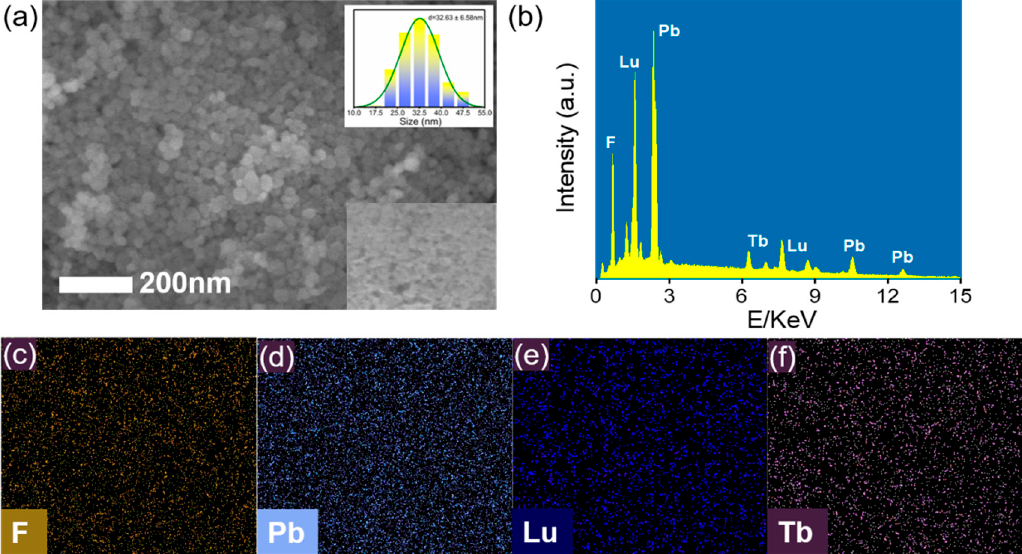
Figure 2. SEM image ( a ), EDX spectrum ( b ), and corresponding EDX mapping results ( c – f ) of the EDTA coated Pb 4 Lu 3 F 17 : Tb. Inset in ( a ) is the corresponding histogram of size distributions.